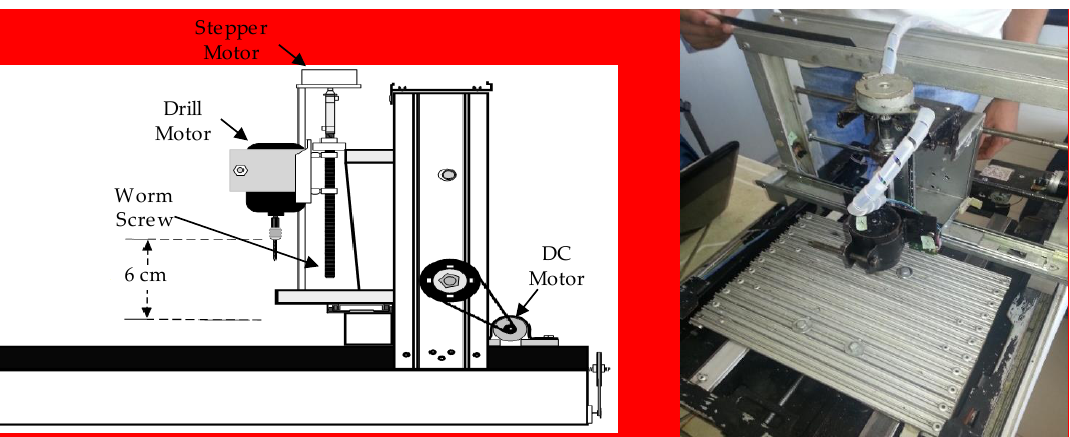
Figure 5. Mechanical system of the X axis.